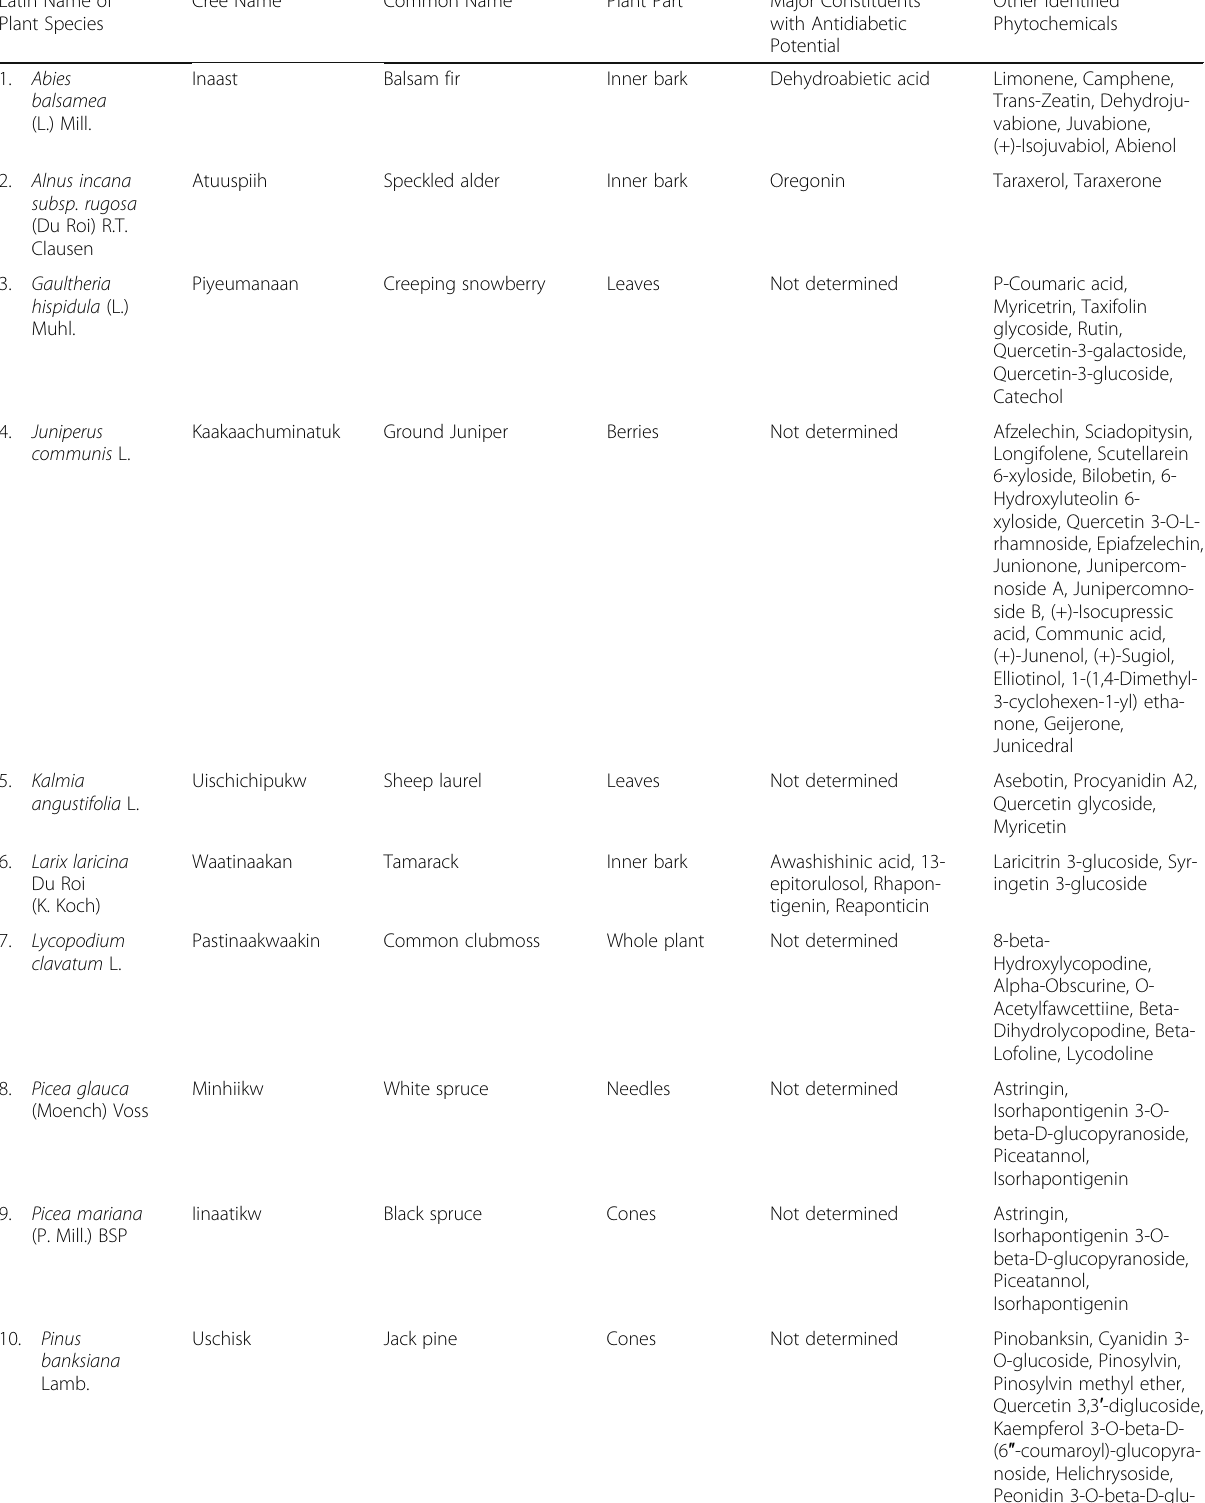
Table 1 Phytochemical characteristics of 17 Cree plant species Latin Name of Plant